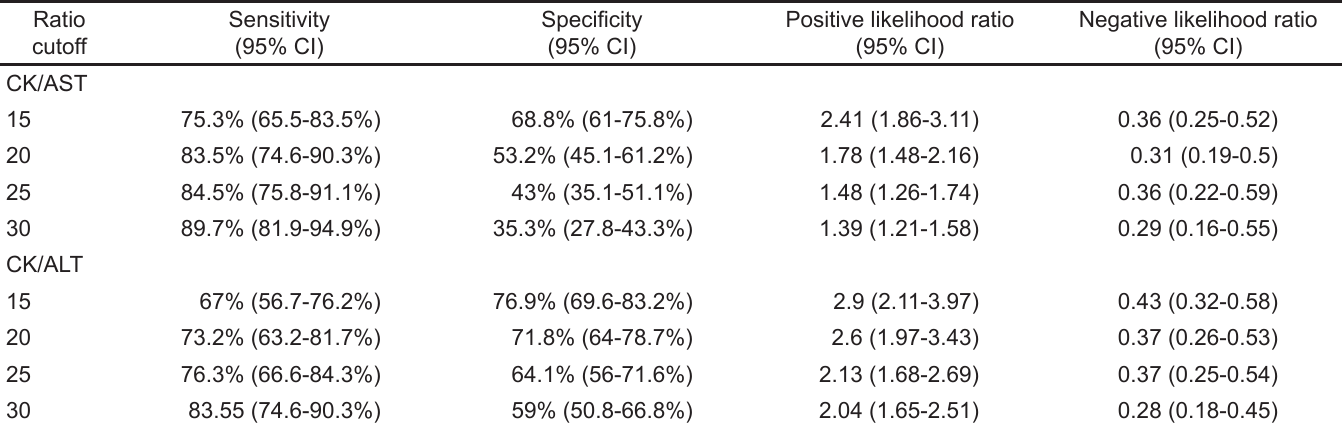
Table 2. Sensitivity and specificity of different CK* to transaminase ratio cutoffs.